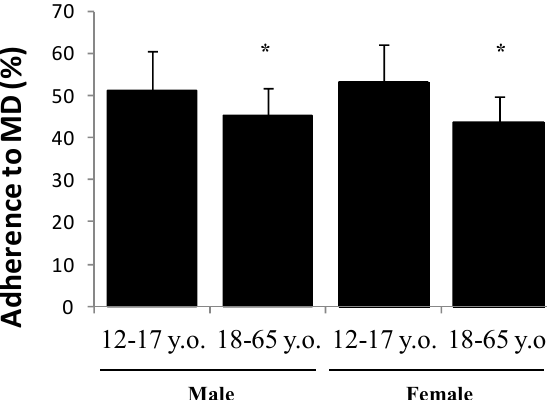
Figure 1. Adherence to Mediterranean dietary (MD) pattern expressed as a percentage (%) ± standard deviation (SD) in male and female subjects studied. y.o.: years old. Statistically-significant differences: * p < 0.05.